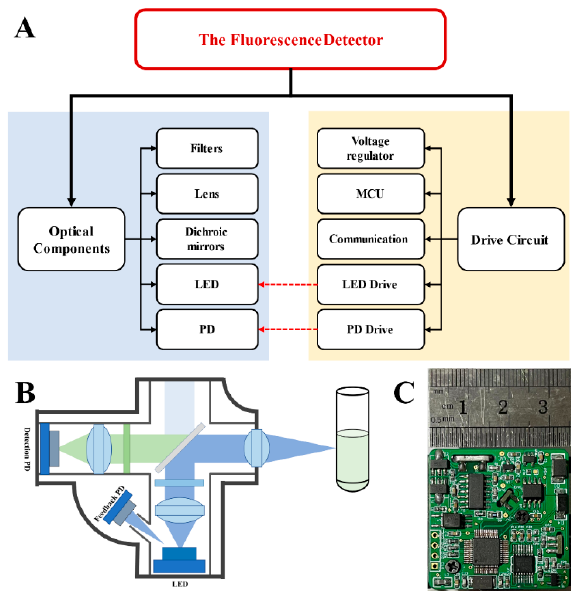
Figure 1. Overall structure of the detector: ( A ) a functional block diagram of the fluorescence detector, including optical components and drive circuit; ( B ) a schematic diagram of the optical path—blue indicates the excitation light, and green indicates the fluorescence emitted by sample; ( C ) a printed circuit board (PCB) picture of the fluorescence